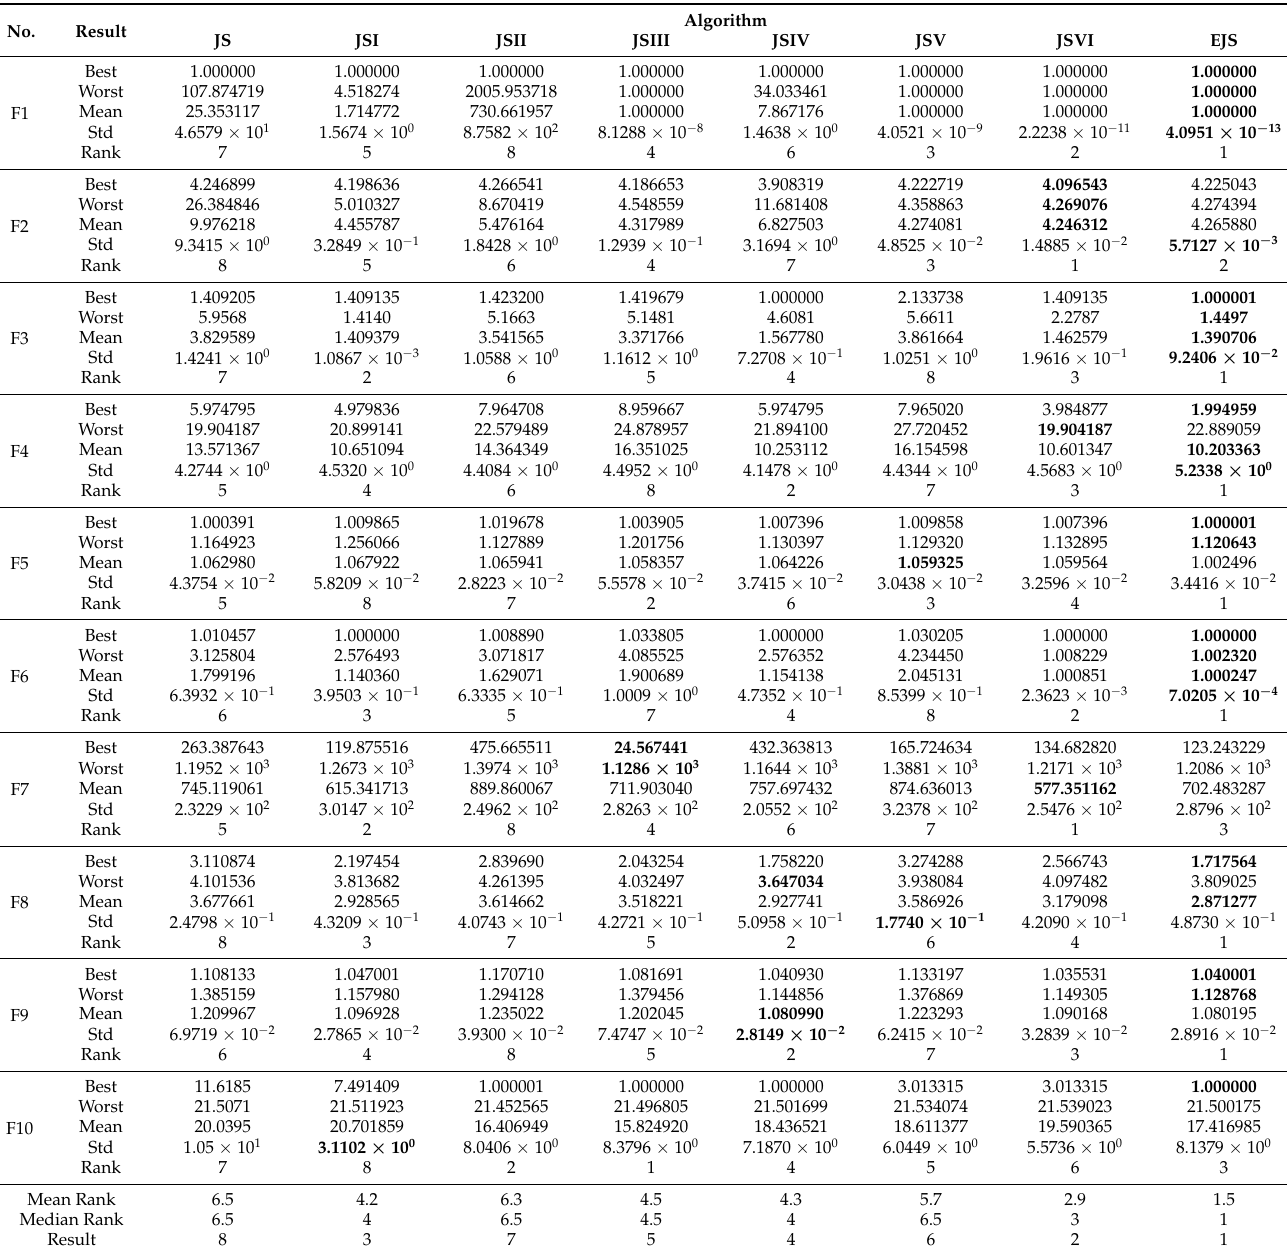
Table 2. Comparison results of different improvement strategies on the CEC2019 benchmark test